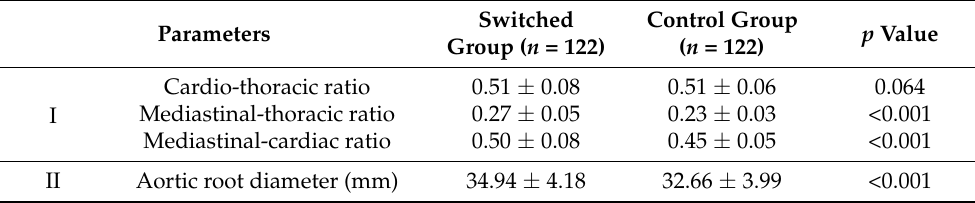
Table 2. Comparison of simple chest radiographic and echocardiographic parameters between